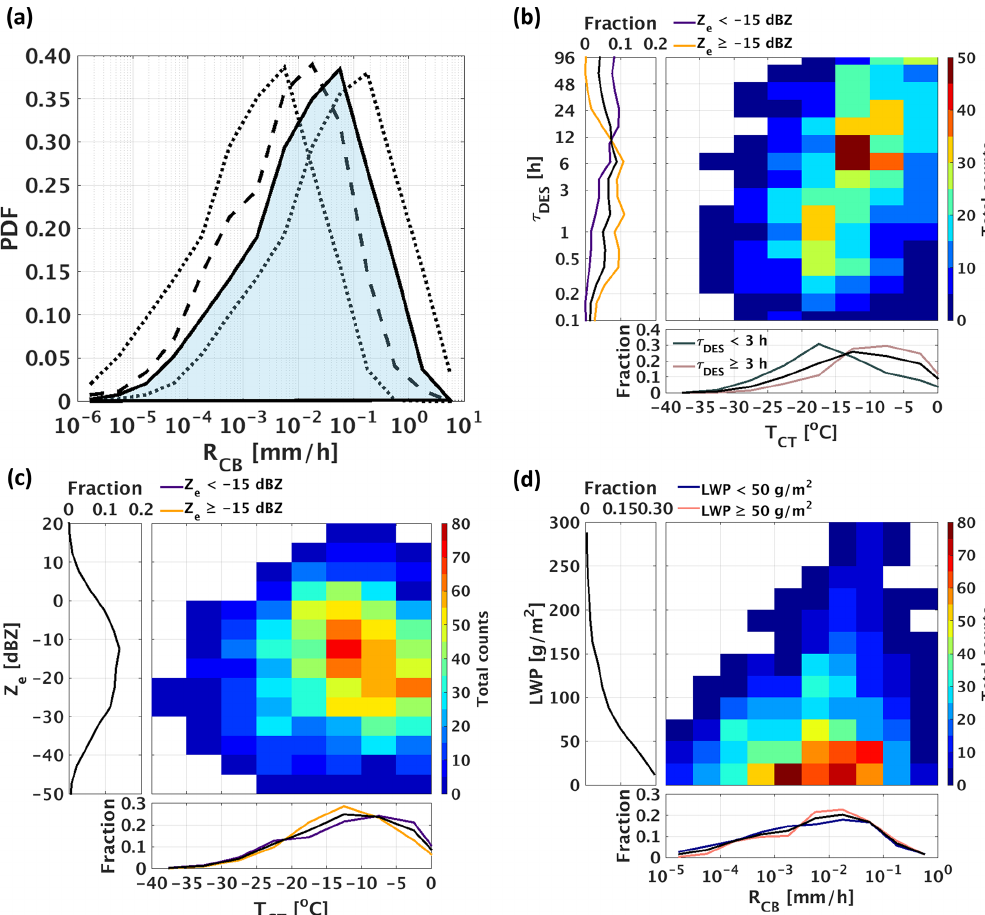
Figure 3. Precipitation characteristics over the NSA: (a) estimated cloud base precipitation rate ( R CB ) probability density function (PDF; calculated over log10 of R CB with a logarithmic bin width of 0.5) over all sampled cases (solid + shaded; 5554 samples) and single-layer cases (dashed; 1591 samples). Dotted curves denote the PDF using R CB at its uncertainty range edges over all samples. (b, c, d) Joint histograms over single-layer cases of precipitation loss timescale τ DES (see Sect. 5) versus T CT , KAZR Z e immediately below supercooled cloud base versus T CT , and LWP versus R CB . The τ DES and R CB histogram bins have base 10 logarithmic bin widths of 0.2 and 0.5, respectively. Integrated occurrence fractions are shown in the side